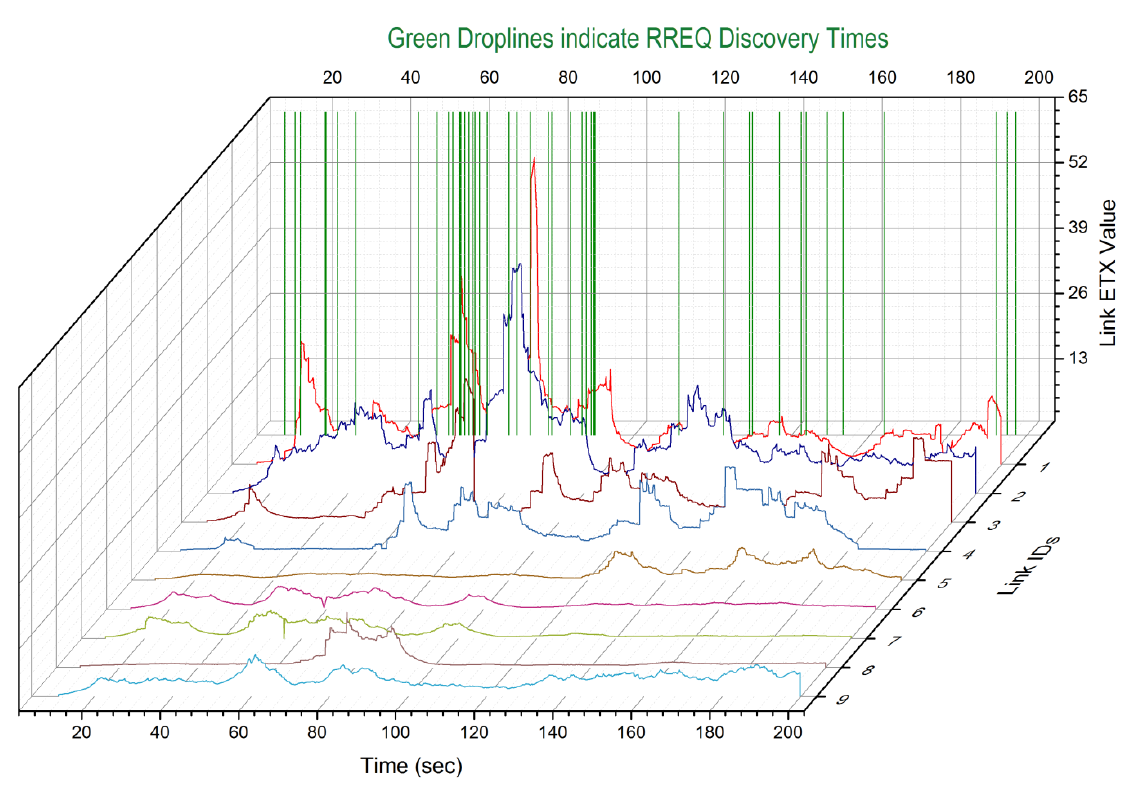
Figure 3: Link ETX estimate variation and route